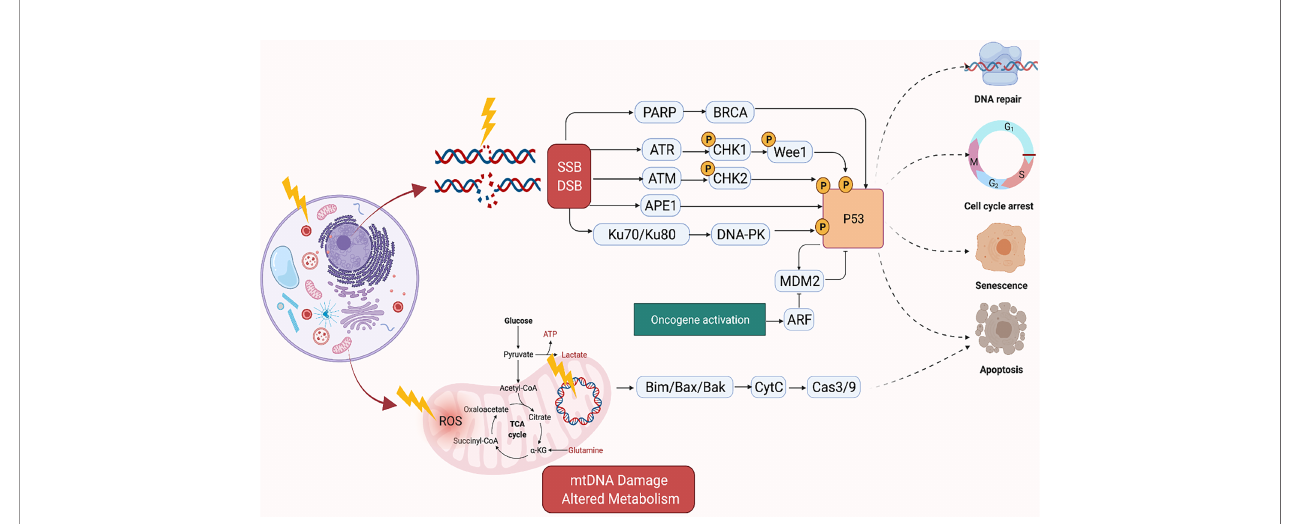
FIGURE 1 | Mechanism of DNA Damage Induced by Ionizing Radiation. Created in